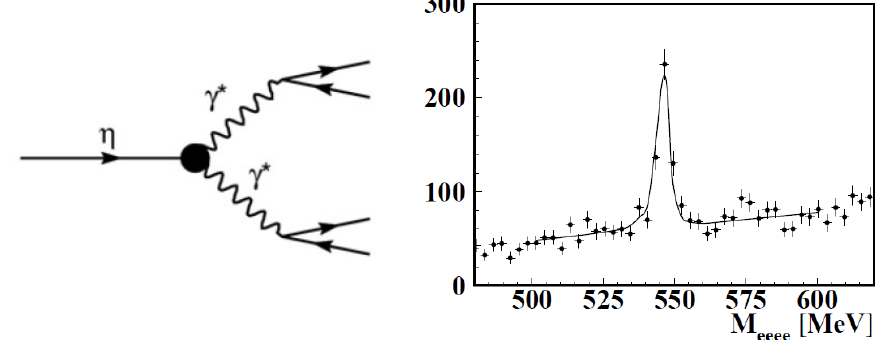
Fig. 2. Left: Feynman diagram for the  →e + e − e + e − decay. Right: fit to the e + e − e + e − invariant